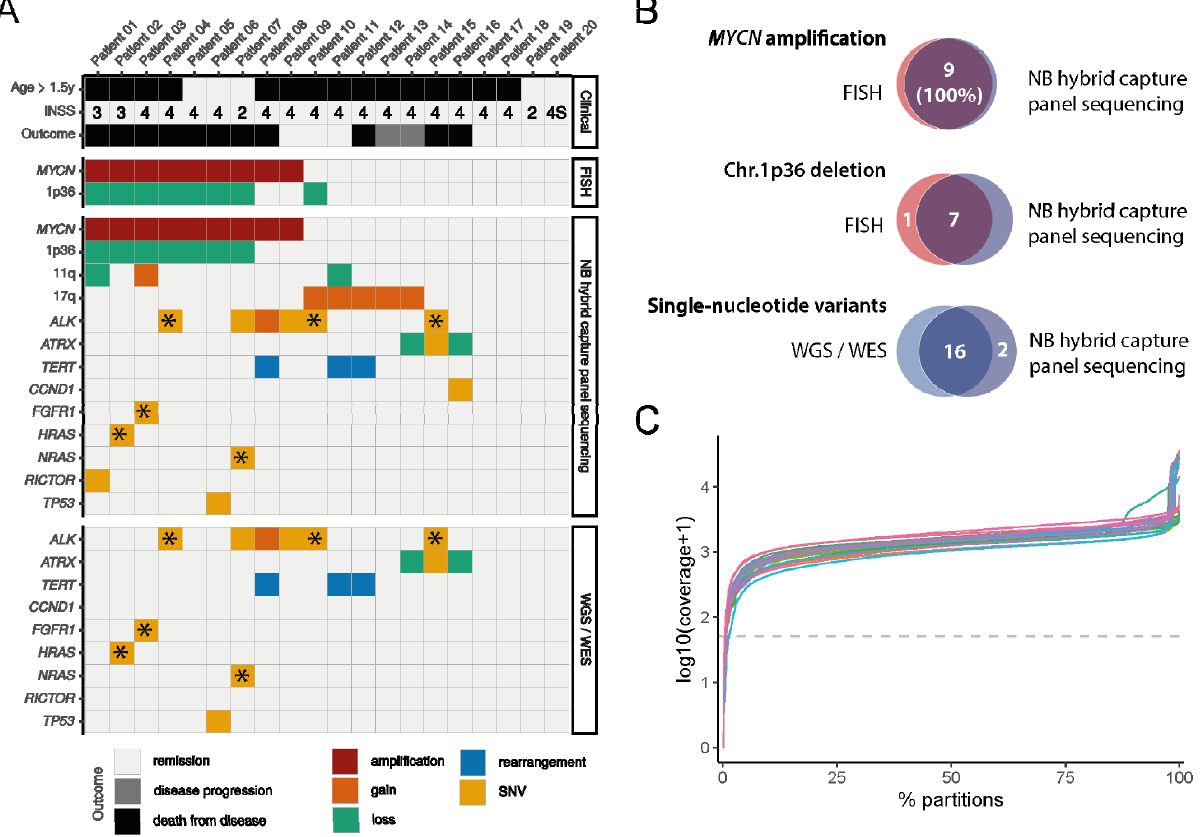
Figure 2. ( A ) Oncoplot displaying covariates and alterations detected with routine diagnostic FISH, the NB-HCPS assay, and WGS or WES in our neuroblastoma reference cohort. Mutations marked by stars (*) are highly likely to be involved in cancers (Tier 1), as reported in the Catalogue of Somatic Mutations in Cancer (COSMIC, Release v92), and were similarly found within the NB-HCPS assay and WGS or WES. ( B ) Venn diagrams displaying concordance of the NB-HCPS assay with routine diagnostic FISH and WGS/WES. ( C ) Sequencing coverage obtained with the NB-HCPS assay in samples of the reference cohort.